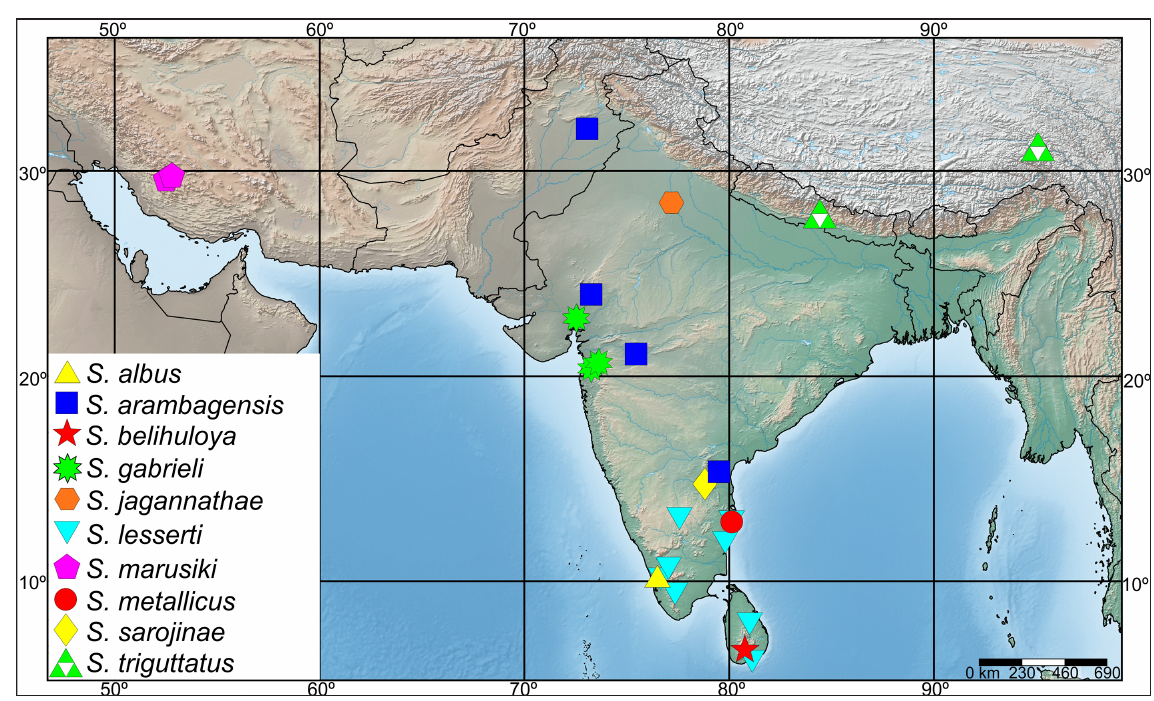
Fig. 509. Collecting localities of ten Asian species of Stenaelurillus Simon, 1885.